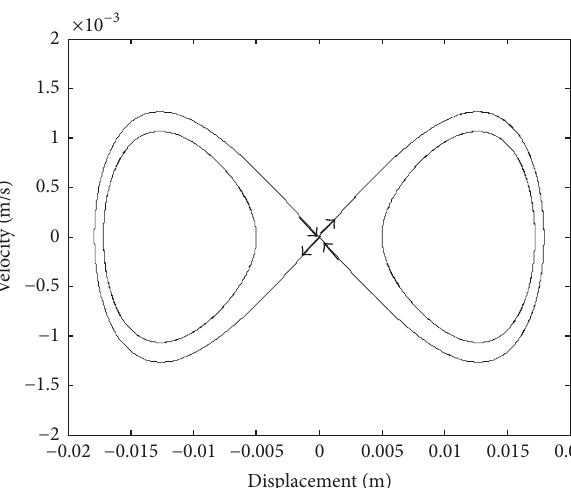
Figure 4: Numerical simulation for SC, for ( 𝐾 1 , 𝐾 2 ) = (0.02, 0.0).